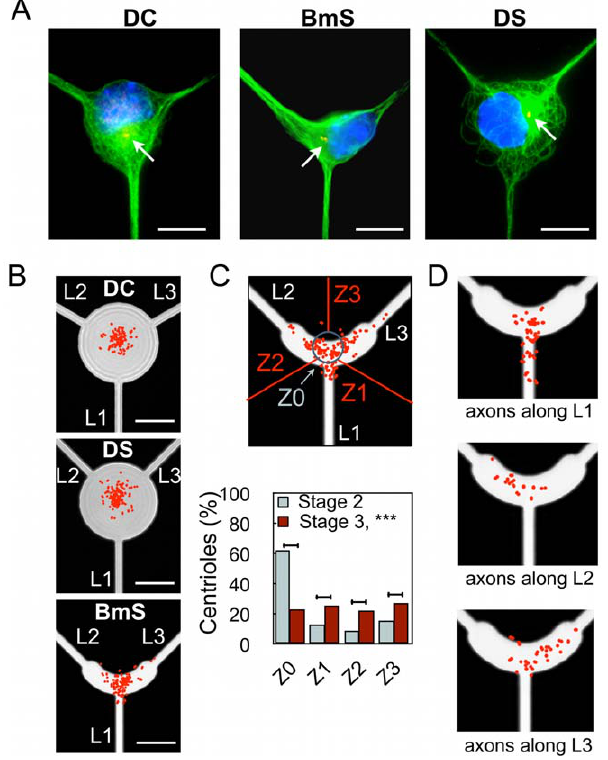
Figure 2. Effect of soma constraints on centrosome position. (A) Microtubule labeling (green), highlighting the different organizations of microtubules in DC, BmS, and DS patterns. Nuclei (blue) and centrioles (red) stained with antibodies against c -tubulin. Red arrows point to the centrioles. (B) Superimposition of density maps for centrioles and corresponding patterns ( n =154, 168, and 160 from stage 2 neurons for the DC, DS, and BmS patterns, respectively). (C) Centrosome distribution in stage 2 (1 DIV) and 3 (3 DIV) neurons grown on BmS patterns. Upper panel: Scheme of BmS pattern indicating the regions of interest Z0-Z3; with the scatter plot of centriole distribution superimposed (red dots, stage 3). Percentages of centrioles in each region of interest with inset showing the density map of the upper scatter plots superimposed on dashed lines delimiting the patterns. ( n =160, stage 2 neurons; n =184, stage 3 neurons). (D) Centriole positioning (red dots) and axonal localization in neurons grown over the BmS pattern. ( n =31, 12, and 20 neurons for the L1, L2, and L3 directions, respectively).